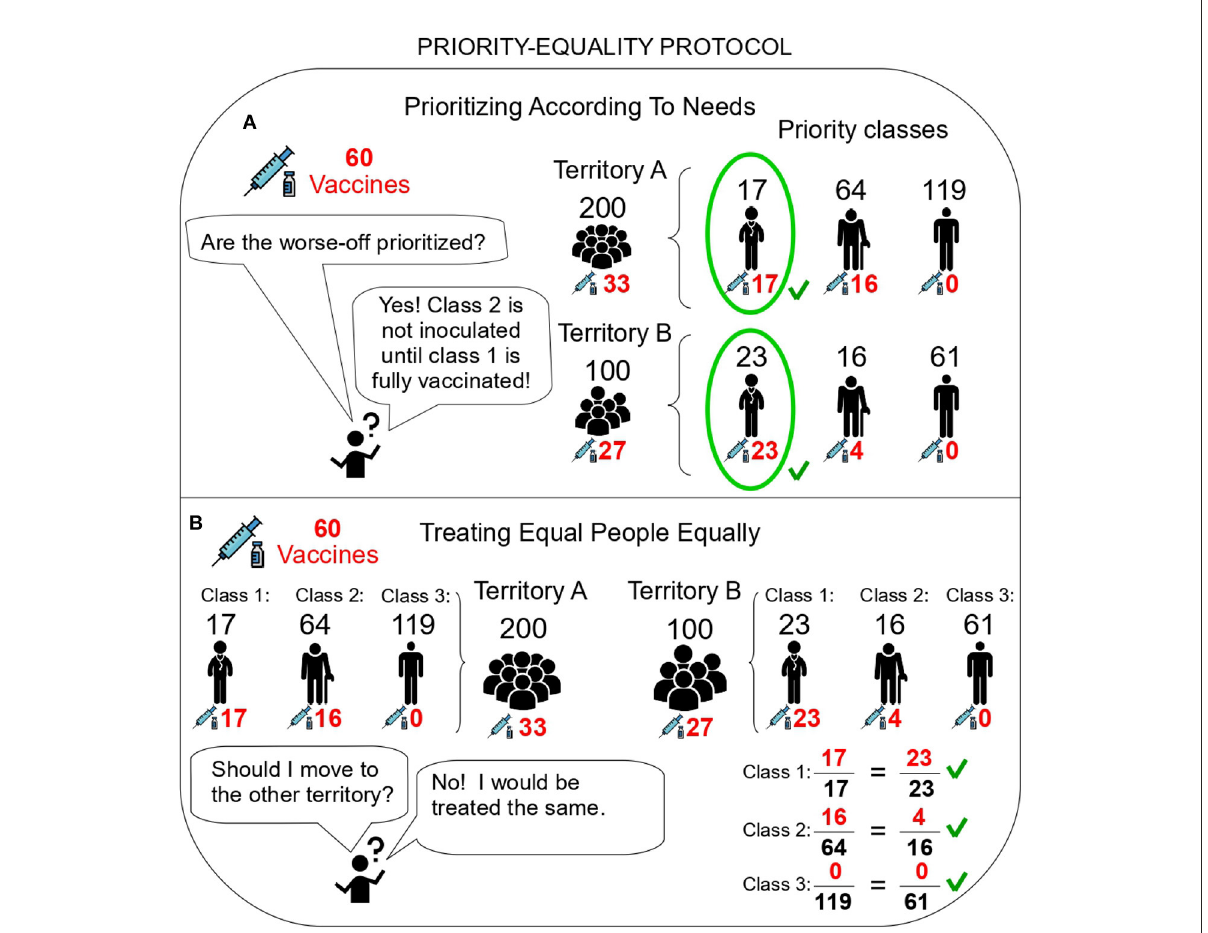
FIGURE4 The Priority-Equality protocol satisfies ethical principles. (A) Prioritizing According To Needs . The highest priority class is fully covered in both territories. The remaining vaccinations (20) do not suffice to cover the second priority class, hence that class is rationed in both territories. Other classes are excluded. (B) Treating Equal People Equally . For the second class, vaccinations are allocated proportionally to the size of that class across the territories ( R 2 A = 16 < 64, R 2 B = 4 < 16). Hence, vaccination rates are identical. Icons made by Freepik from Flaticon